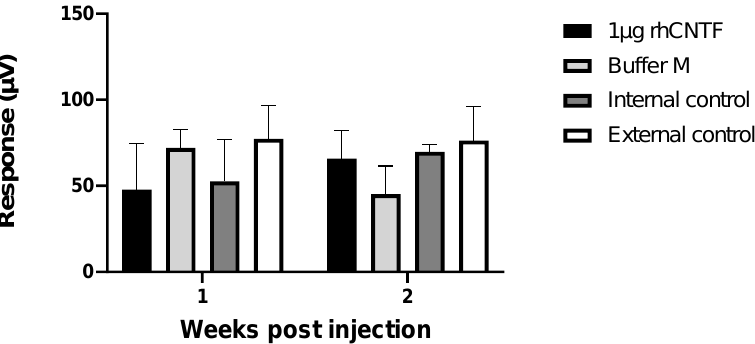
Figure 11. Mean and SD of photopic beta wave amplitudes at stimulus intensity 1 cd × s/m 2 one and two-weeks post-injection. No statistically significant difference in the responses between any of the treatment groups at different time points could be detected (n = 6).